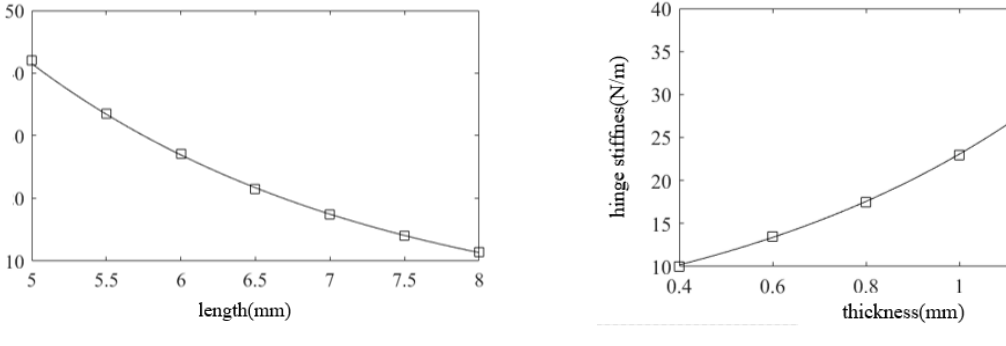
Figure 3. ( a ) Straight beam length; ( b ) minimum thickness.